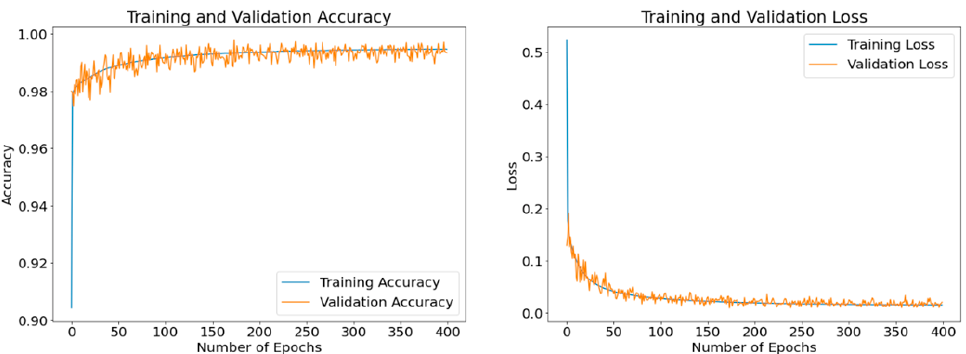
Figure 11. Accuracy and loss curves generated by SGD optimizer after model training (blue) and validation (orange). A batch size of 8 and 400 epochs are employed.